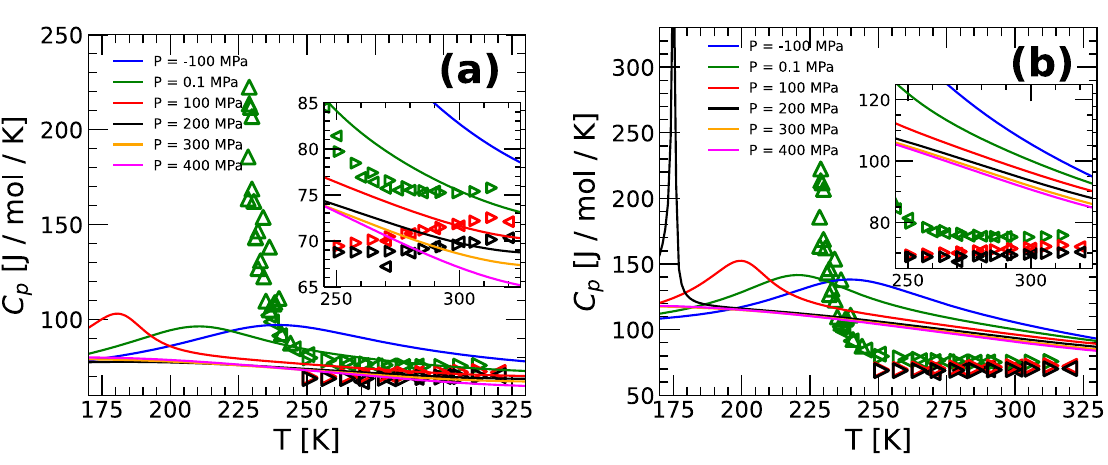
Figure 5. ( a ) Heat capacity C P ( T ) of q-TIP4P/F water for P = -100, 0.1, 100, 200, 300, and 400 MPa. C P ( T ) was calculated by using Eq. (3) and the H ( T ) expression obtained from the TSEOS and PIMD simulations (solid lines). Experimental data are indicated by empty triangles (left-triangles from Refs. 4,69 ; right-triangles from Refs. 59 ). ( b ) Same as ( a ) for the case of classical MD simulations. The experimental data from Pathak et al. 10 (green up-triangles) show a maximum at T ≈ 228